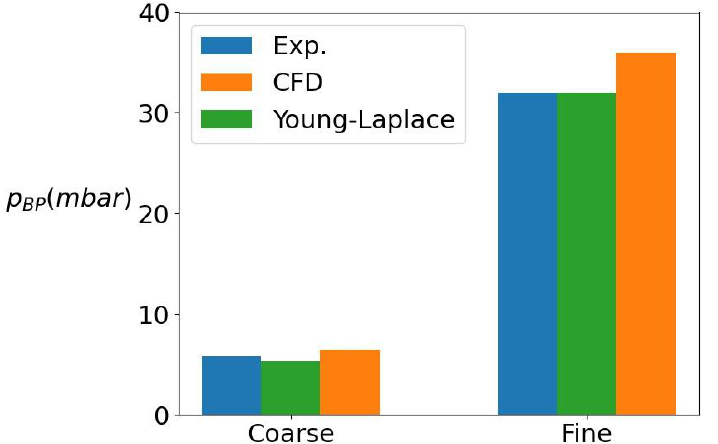
Figure 10. Comparison between the threshold pressure obtained from the approximated Young– Laplace equation, experimental measurement, and CFD simulations.